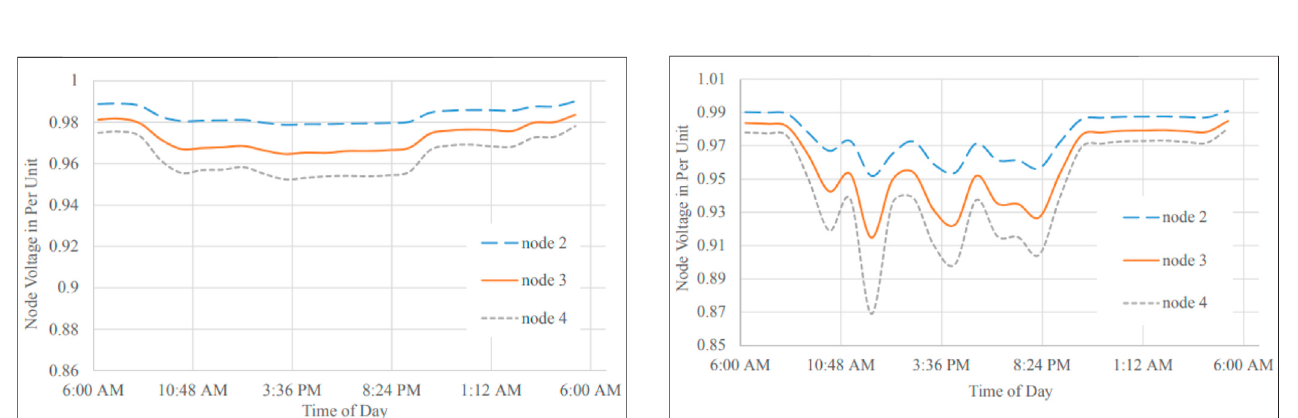
FIGURE 9 | Utility forecast 02 node voltages with reschedule.